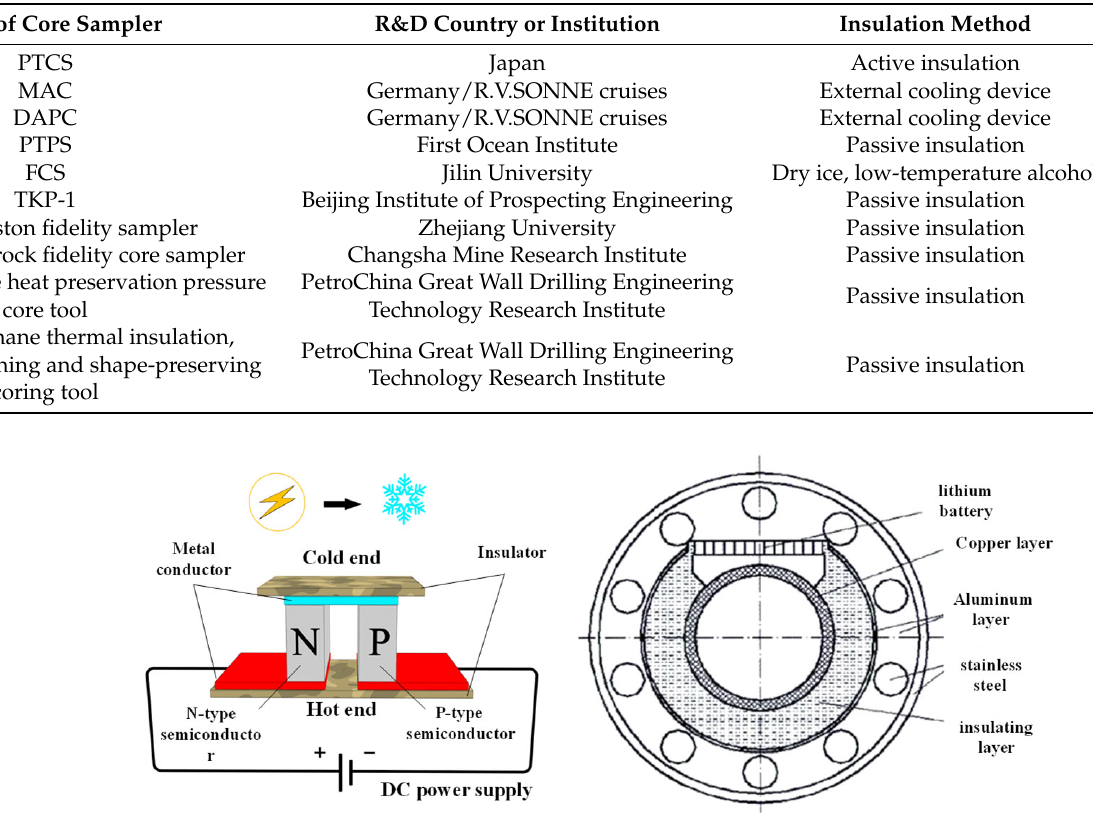
Figure 3. Schematic diagram of active and passive heat preservation of PTCS.